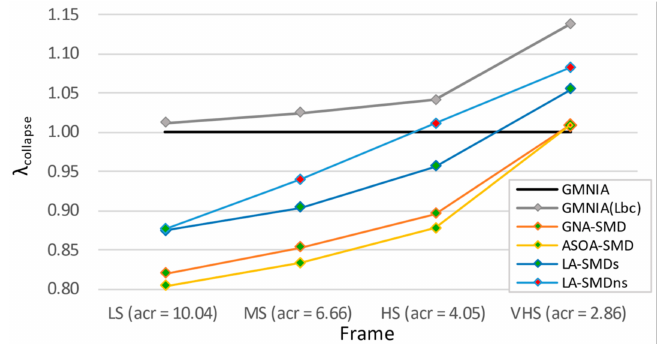
Figure 13. Comparison of the ultimate load factors of the methods that involve buckling verifications with those of GMNI Analyses taking into account local imperfections either from Table 5.1 of EN 1993-1-1 [1] or from the Equation